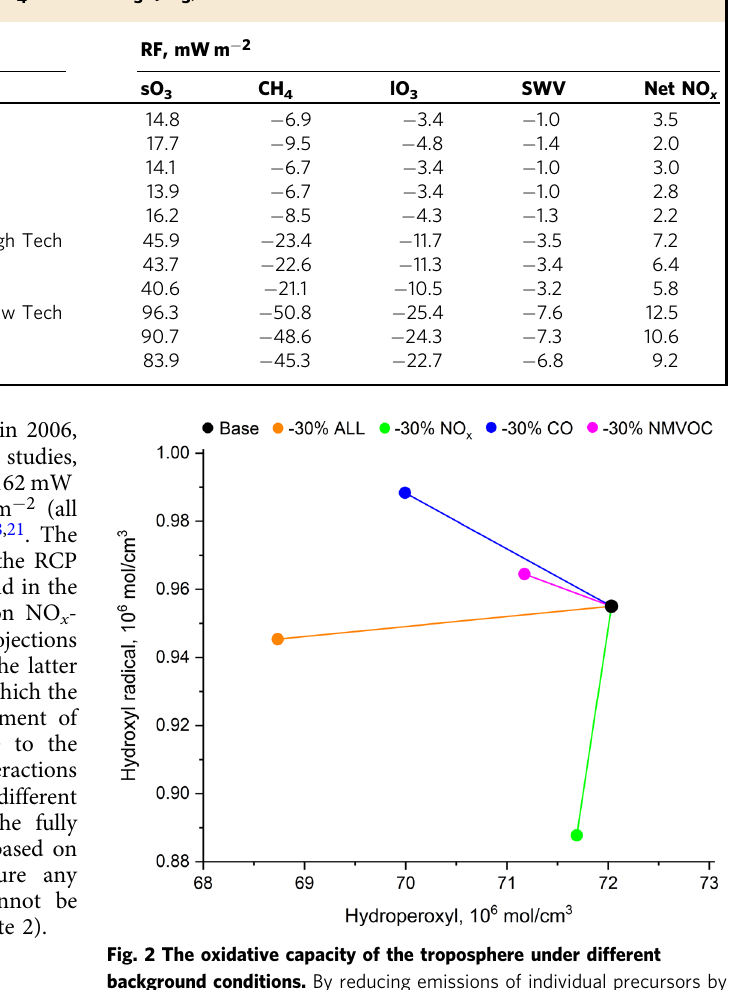
Table 1 Aircraft NO x radiative forcing (RF, mW m − 2 ) for different background and aircraft emission scenarios in 2006 and 2050.